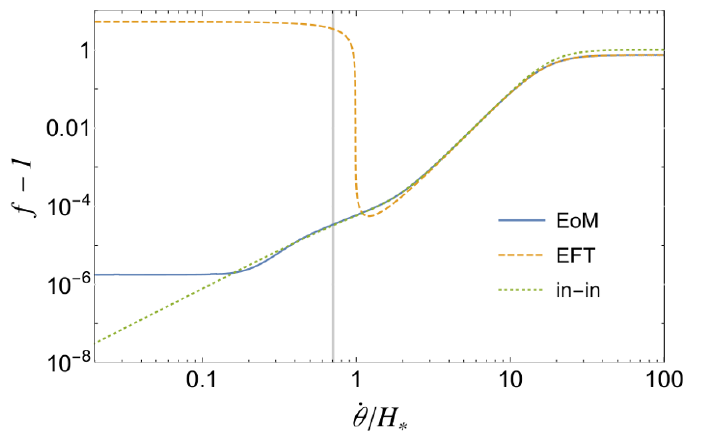
Figure 5 . The ratio f = P (cid:18) =P (cid:3) of the power spectrum with respect to the parameter _ (cid:18) 0 =H (cid:3) in the (cid:18) (cid:3)-rescaling scheme. The vertical line describes the threshold value for the heavy Higgs condition.